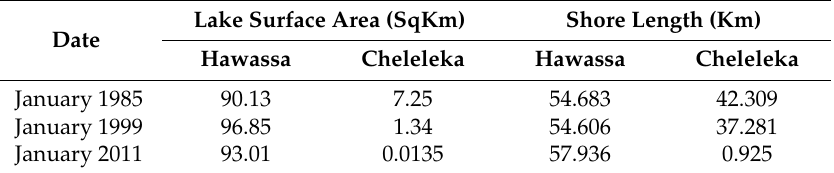
Table 1. Lake area and shore length from 1985, 1999 and 2011 Landsat images.